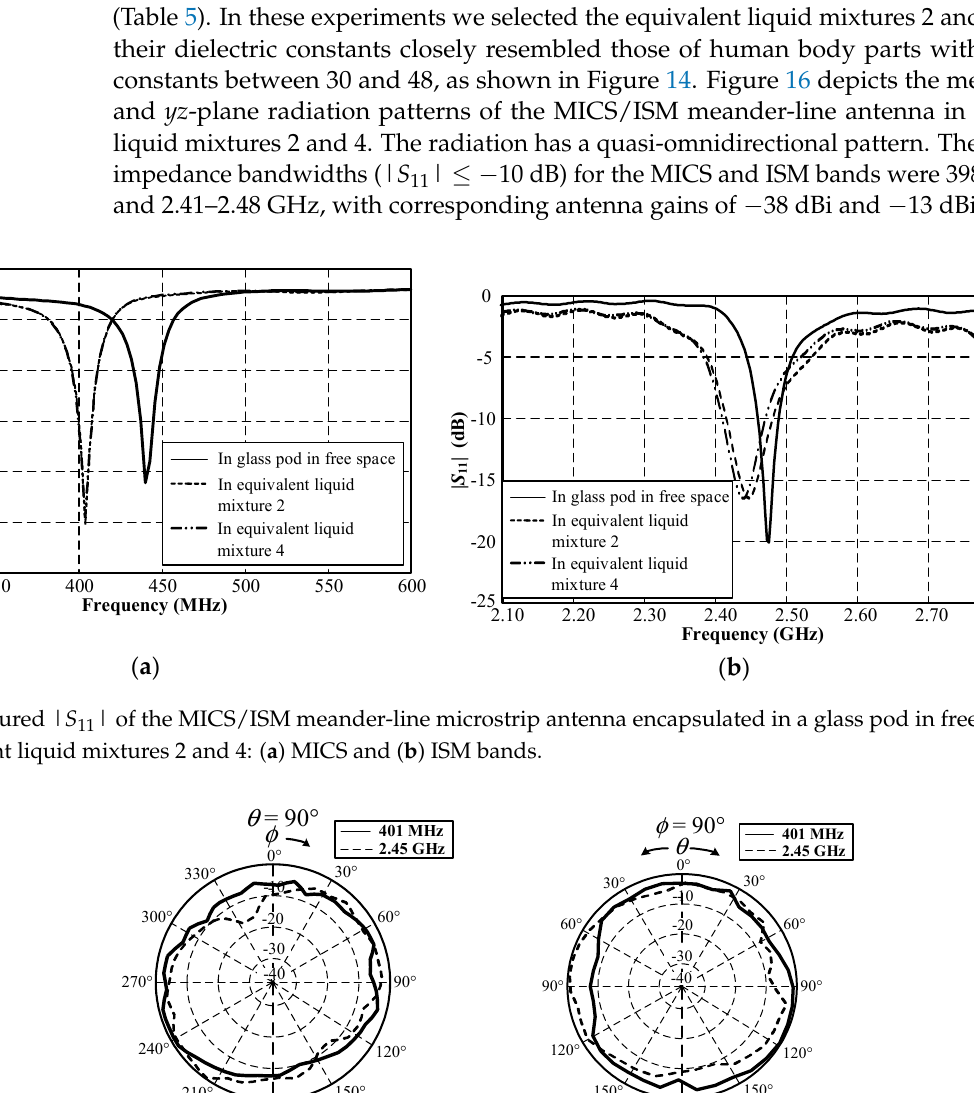
Figure 14. The dielectric constants of nine experimental mixtures of equivalent liquid: ( a ) real part, ( b ) imaginary part.